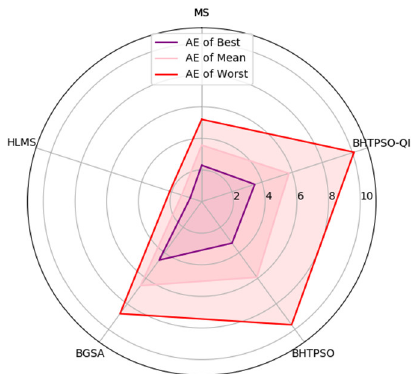
Figure 7. The performance comparison of 5 methods based on AE for Test set III (cb4–cb6).